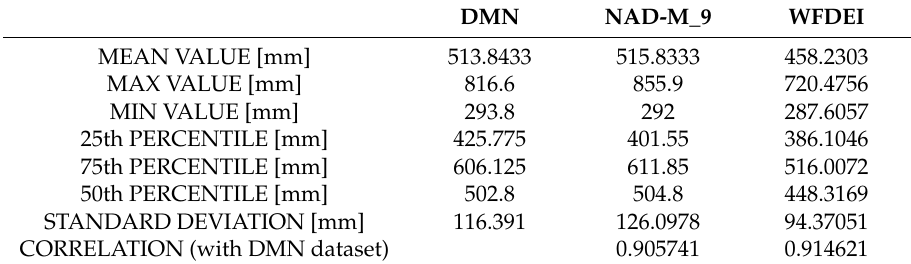
Table 5. Descriptive statistics of DMN, NAD-M_9 datasets and